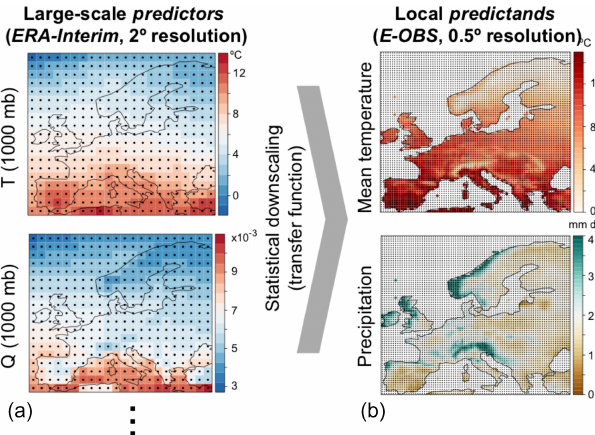
Figure 1. Climatology for (a) two typical predictors (air tempera- ture, T , and specific humidity, Q , at 1000mbar), as given by the ERA-Interim reanalysis (2 ◦ ), and (b) the observed target variables of this work, temperature and precipitation from E-OBS (0 . 5 ◦ ). Dots indicate the center of each grid